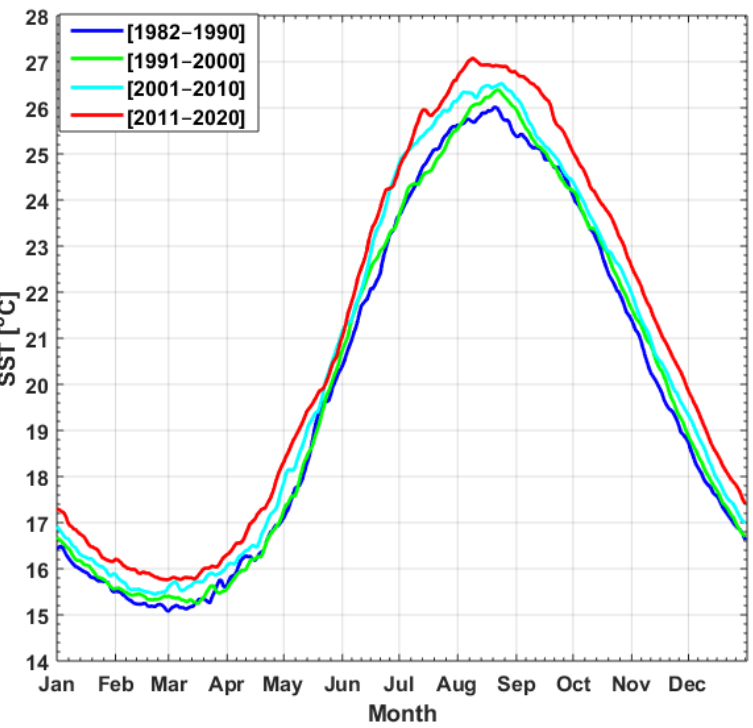
Figure 2. Temporal evolution of the basin averaged plotted SST in (°C) where P 1 (1982–1990) in continuous blue line, P 2 (1991–2000) in continuous green line, P 3 (2001–2010) in continuous cyan line and P 4 (2011–2020) in continuous red line.